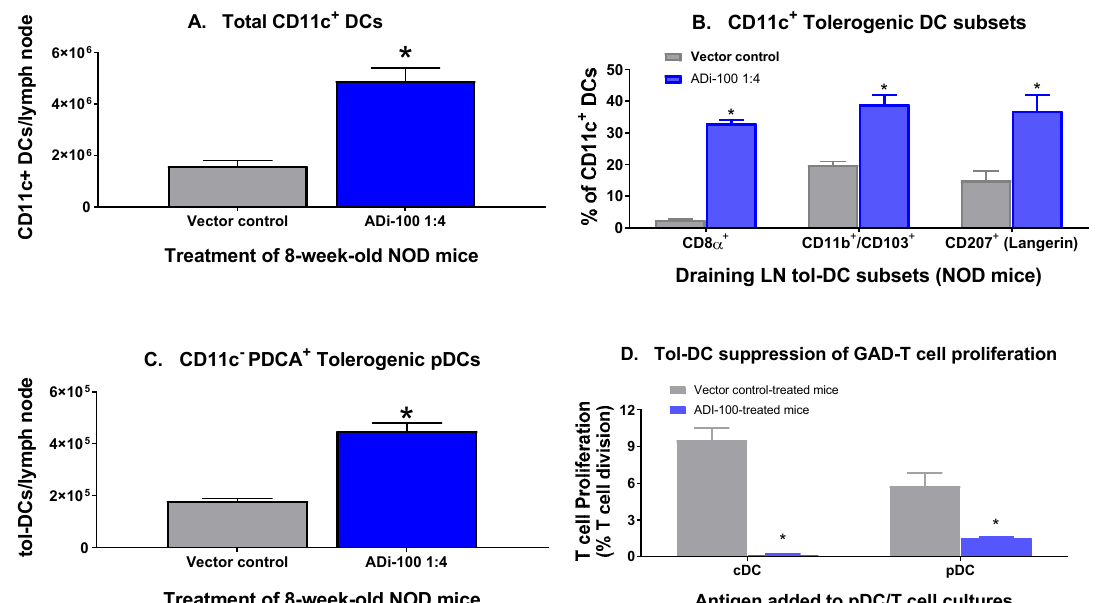
Figure 1. ADi-100-induced tol-DC subsets in draining lymph nodes of NOD mice. Groups of 8-week-old female NOD mice were vaccinated with vector plasmid DNA alone (control) or ADi-100 1:4 (BAX 10 µ g + msGAD55 40 µ g). After 4 days of vaccination, leukocytes were isolated from draining lymph nodes (inguinal) and DC populations were analyzed via flow cytometry. The following are phenotypic definitions of DC populations: total classical DC population, MHC Class II + / CD11c + ( A ), tol-DC lymphoid tissue-resident populations, MHC Class II + / CD11c + / CD8 α + ( B ) and MHC Class II (IAg 7 ) + / CD11c − / PDCA + (plasmacytoid DC); ( C ), and tissue-migratory / Non-lymphoid tissue tol-DC populations, MHC Class II + / CD11c + / CD207 + ( B ) and MHC Class II + / CD11c + / CD11b + / CD103 + ( B ). * p < 0.001 compared to vector control cohort (two-tailed t test). CD11c + (cDC; CD11c + CD8 + Integrin α v β 8 + ) and CD11c − (plasmacytoid DCs, pDC; CD11c- / PDCA + ) tol-DC populations prepared from splenocytes of vector control- or ADi-100 1:4-treated NOD mice were cultured with GAD-stimulated (3-day) CD4 + T lymphocytes from untreated NOD mice and rhIL-2 for 72 h and proliferation was assessed via CSFE staining and flow cytometry ( D ). Cell division was analyzed using FlowJo software and proliferation is reported as the percentage of dividing cells per total CD4 + T cells.